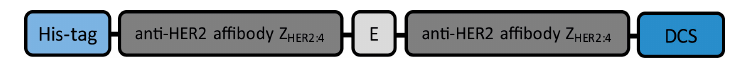
Figure 1. The (Z HER2:4 ) 2 DCS diaffibody construct is composed of two Z HER2:4 units separated by a single glutamate residue (E), a 6× His-tag at the N-terminus, and a drug conjugation sequence (DCS) at the C-terminus.